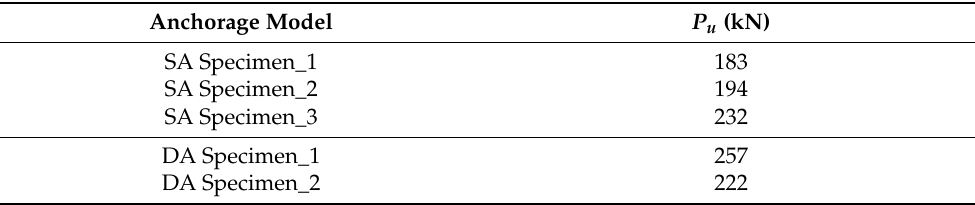
Table 10. Proposed anchorage: experimental tests. Values of the ultimate load P u